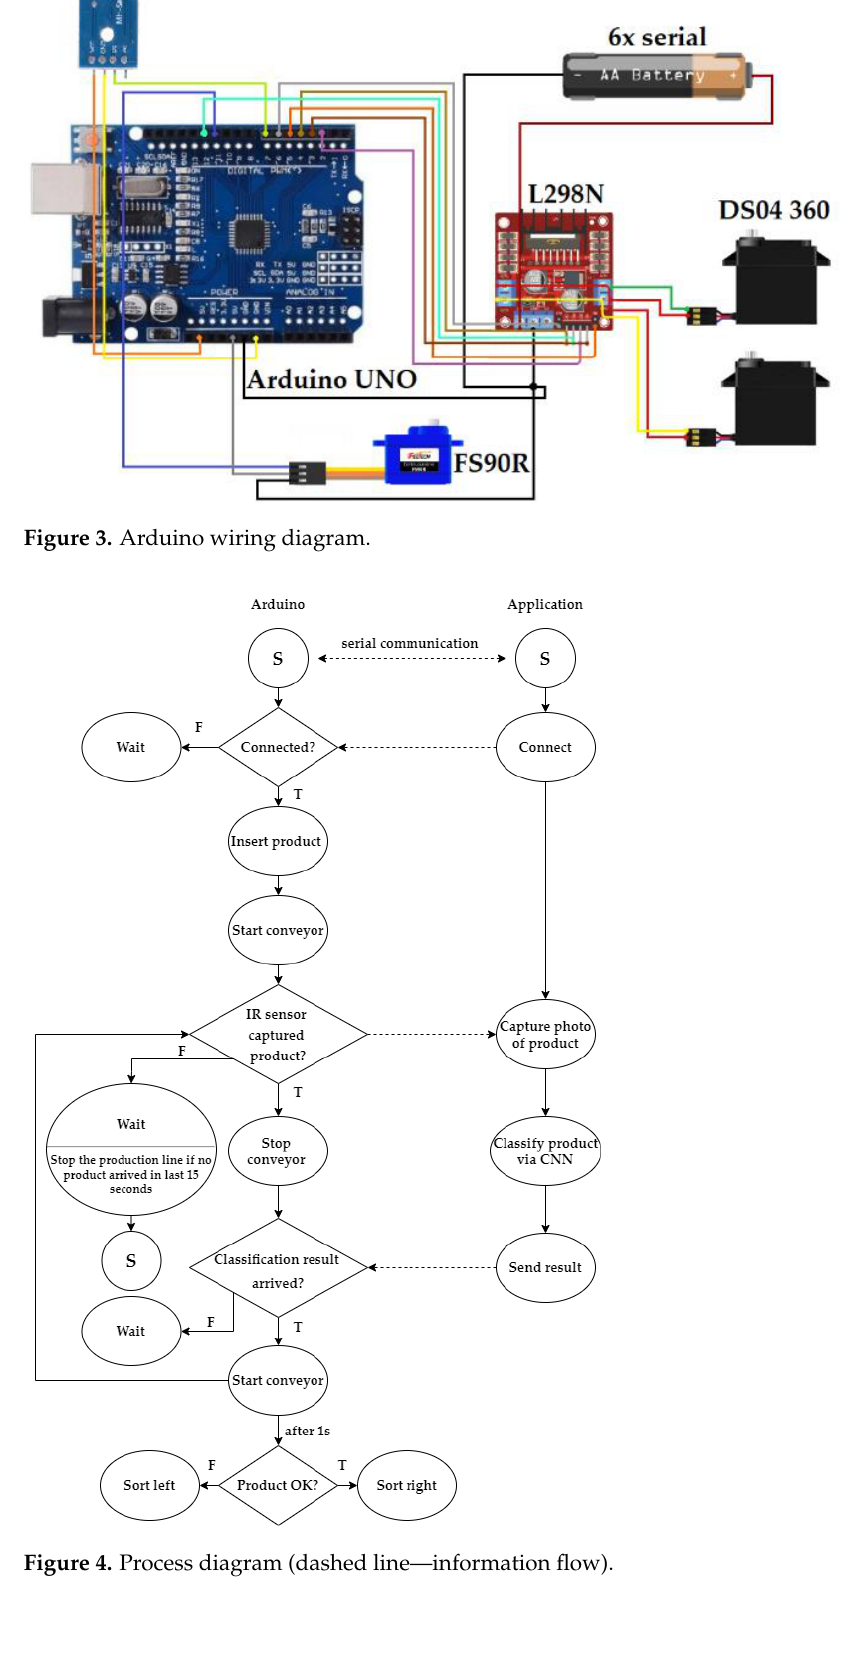
Figure 5. GUI of the application during product classification in the first task.